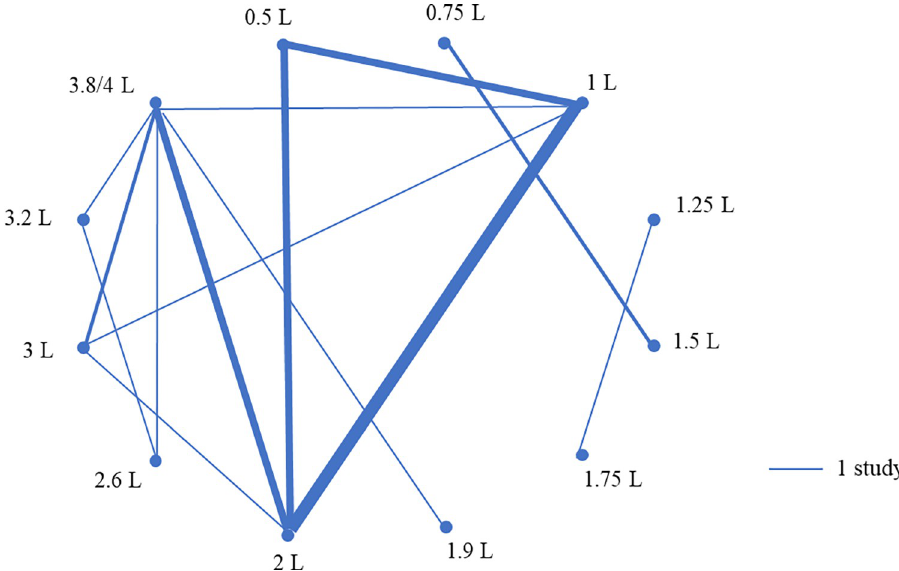
Fig 4. Schematic summary of the volumes of colostrum compared in 17 controlled studies that compared different quantities of maternal colostrum fed at first feeding. Quantity fed at a proportion of body weight was converted to liters based on the average body weight reported in 2 studies. The thickness of lines represents the number of studies conducted between the combinations of treatment groups.